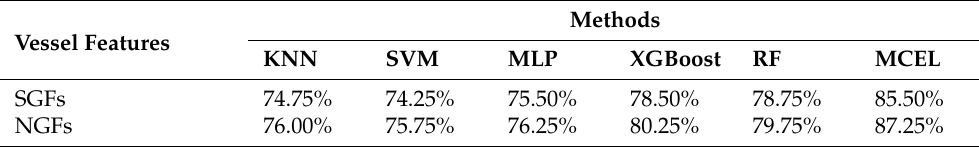
Table 2. Ship classification accuracy of different methods on the AIS test set. Vessel